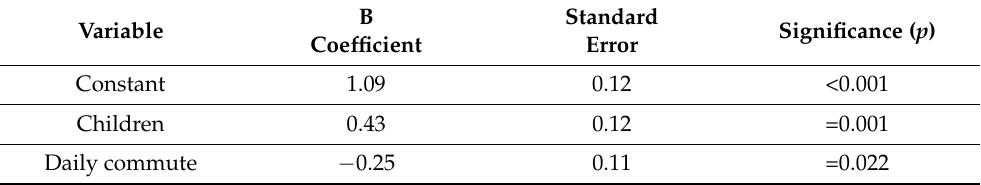
Table 7. Backward selection type of multiple logistic regression for